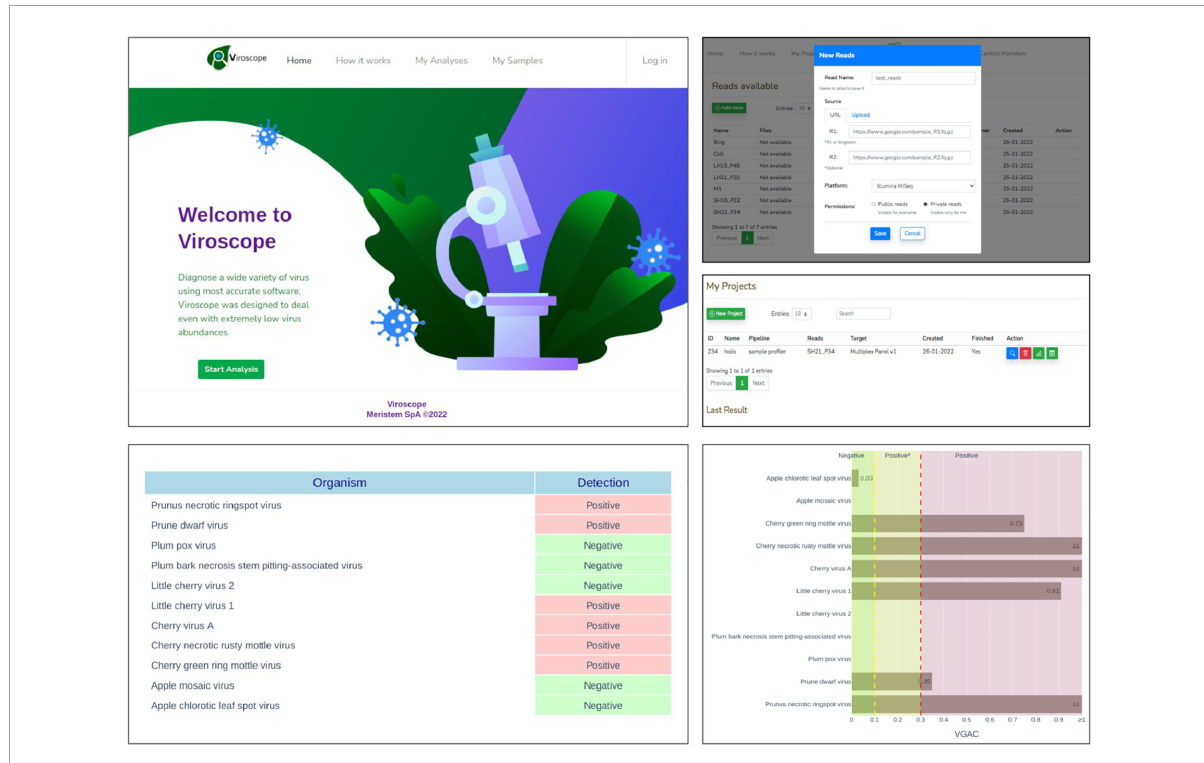
FIGURE9 Viroscope.io. The Viroscope web application enables virus plant diagnostics using HTS data. It provides a user-interface to perform the Viroscope pipeline, and yields the VGAC (viral genome assembly coverage) metric as well as the presence of replicases to interpret the data and perform diagnosis. The process involves uploading HTS reads into the read library, selecting an analysis against a specific viral panel using user-inputted thresholds. This generates the analysis which is processed in real-time. The analysis then displays the results in plots that provide the metrics and suggests the diagnosis according to the selected thresholds, which is then confirmed by the user. The background image for the Viroscope.io web app was purchased at Shutterstock.com under a standard